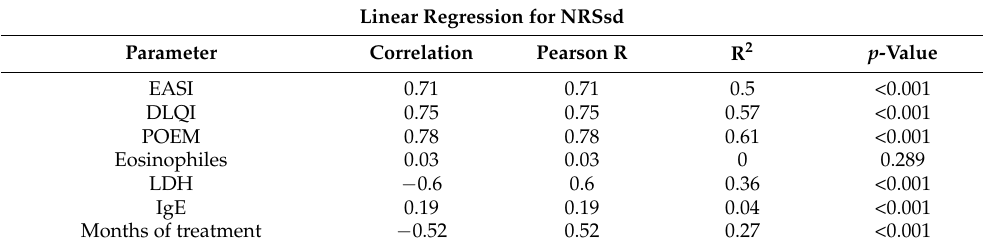
Table 5. Linear regression for